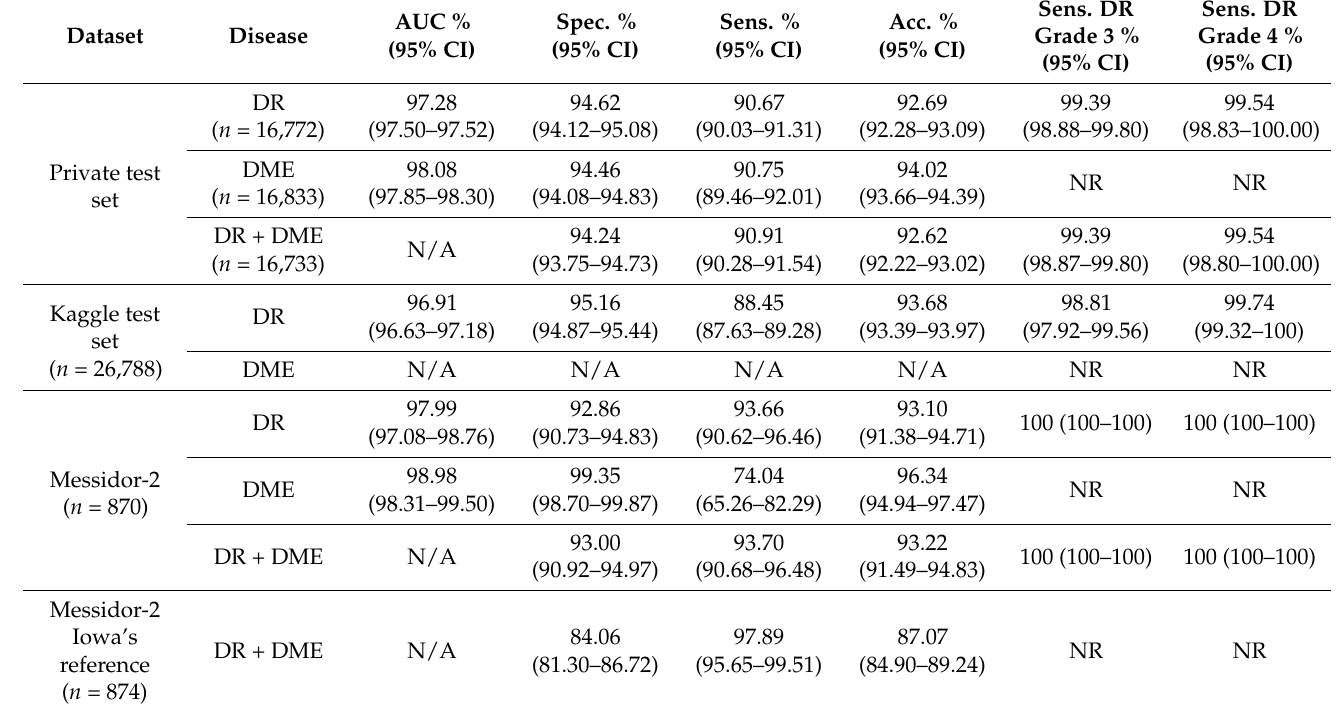
Table 2. Performance evaluation results (given in %) for the test set and the public datasets. Results are for the selected 90% sensitivity operating point. AUC: area under the curve; Spec.: specificity; Sens.: sensitivity; Acc.: accuracy; N/A: not applicable; NR: not relevant. DR grade 3 refers to severe non-proliferative DR and grade 4 to proliferative